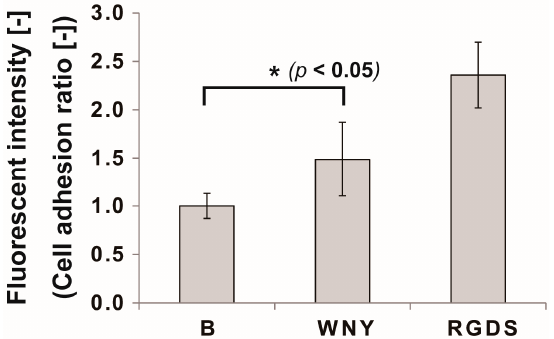
Figure 6. Results of the cell adhesion assay with cellulose disks coated in Col IV-selective adhesion peptide (WNY) or RGDS peptide. Cell numbers were measured by CalceinAM staining of live cells after 1 h of incubation. B: blank disk with no peptide coating. All experiments were performed six times (* p < 0.05, Student’s t -test).